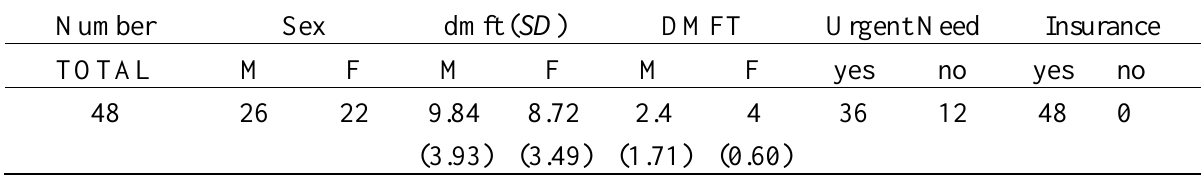
Table 1. Characteristics of Patients Received Dental Care.